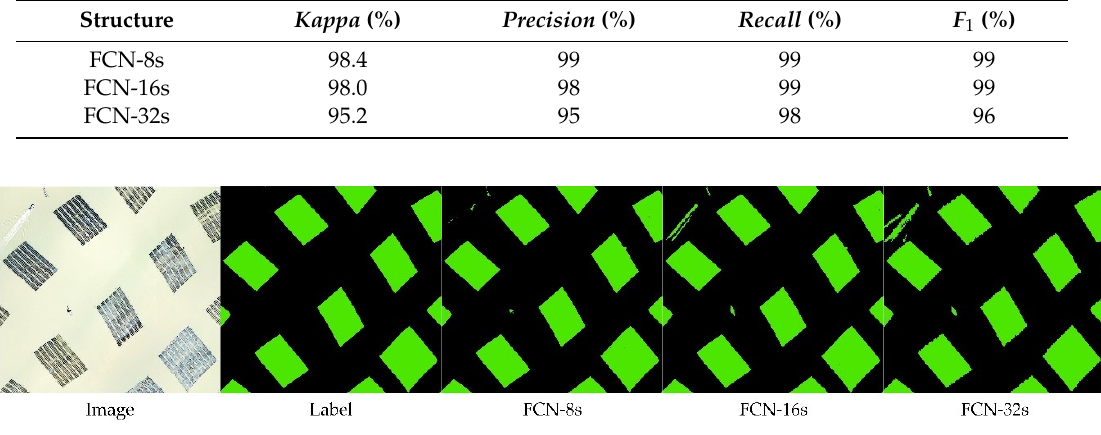
Figure 7. Results of FCN-8s, FCN-16s, and FCN-32s.